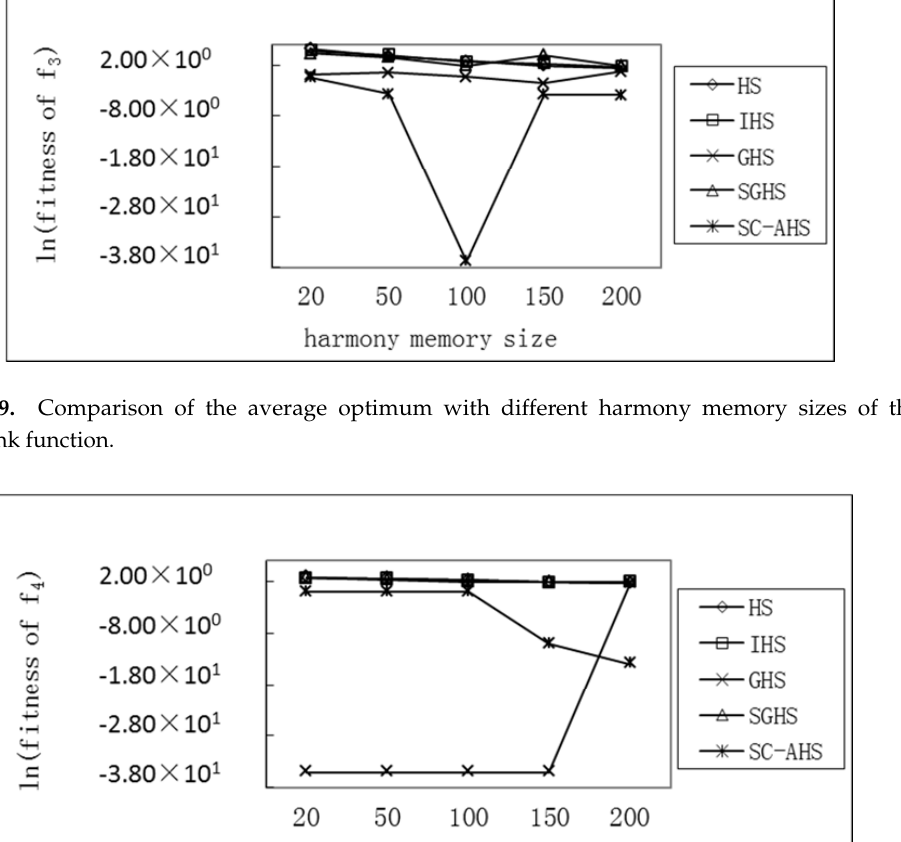
Figure 11. Comparison of the average optimum with different harmony memory sizes of the Rosenbrock function. 5.2.3. Test of SC ‐ AHS Algorithm with Dynamic Parameters Experiment The experiment is mainly to verify that the SC ‐ AHS algorithm has fast convergence performance. The experiment still adopts the conditions of changing parameters, and still adopts two test methods, including varying the number of harmonic components and varying the harmonic memory size, HMS. The effect of changing the parameters under test on the convergence speed of the SC ‐ AHS algorithm is studied. The average optimal value of each function and the number of evolutions are used as a measure of the performance of the SC ‐ AHS algorithm. Test of Average Optimum with Different Harmony Tone Components of the SC ‐ AHS Algorithm The range of the number of harmonic components, N, is from 50 to 100. The other parameters are unchanged. The effect of the change in the number of harmonic components on the convergence rate of the SC ‐ AHS algorithm is shown in Table 5. The comparison of the change of the average optimum value and the sum of the tone components of each function is shown in Figure 12. It can be seen that with the increase in the number of tone components, there is no apparent upward trend in the average optimal value of the functions. Table 5 shows that the number of evolutions of the SC ‐ AHS algorithm is less than 20,000 for single ‐ peak Sphere ( f 1) and Rosenbrock ( f 5) functions, as well as multi ‐ peak Grievenk function ( f 3), and the number of tone components is different, indicating that the SC ‐ AHS algorithm still has a high convergence speed in the high ‐ dimensional case.